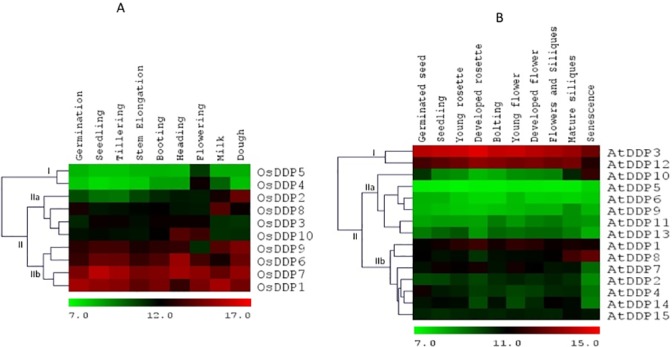
Microarray-based expression pattern of DDP genes during development.Heat maps showing expression patterns of DDP genes from rice (A) and Arabidopsis (B) at different developmental stages as indicated. Heat maps represent hierarchical clustering (using Euclidean distance metric) of average log signal values of DDP genes and were generated using MeV software package. The color bar below the heat maps represent relative expression values with green color representing the lowest expression while as, red the highest expression level. Cluster-grouping represented by Roman numbers followed by letters as discussed in the text.